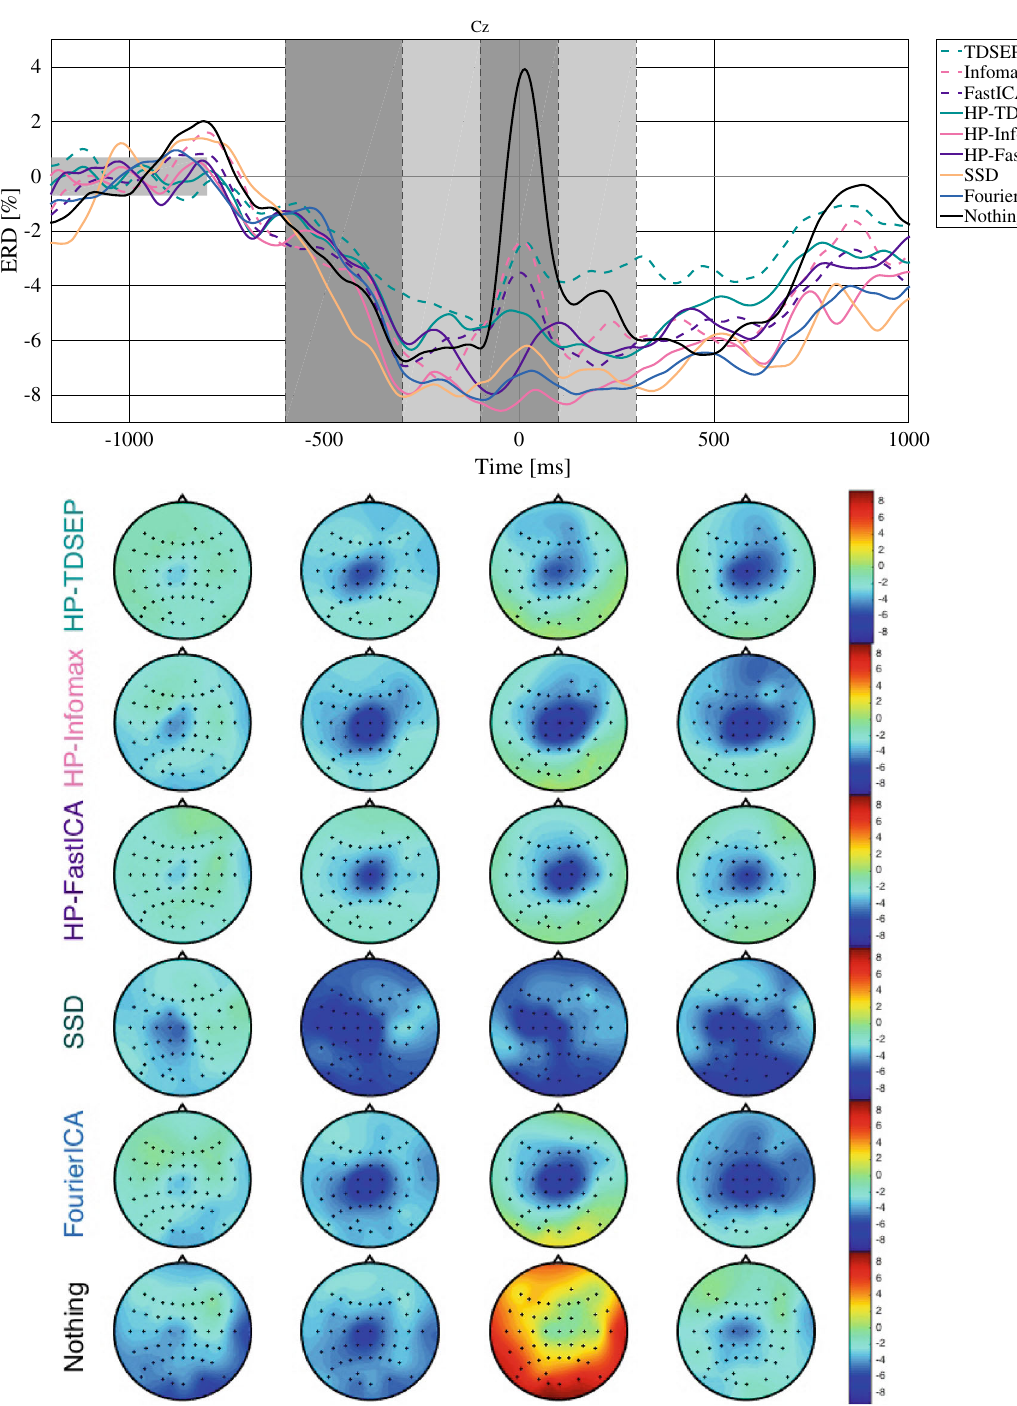
Fig. 2 Grand-average event-related desynchronization (ERD) in the beta band (15–30 Hz), using EMG as a trigger. (Top) time courses of data reconstructed from neural ICs (and for SSD with the five dipolarity score as dependent variable. In contrast to the average ERD peak score, high-pass filtering had a signifi- cant negative effect on the dipolarity score ( F ð 1 ; 102 Þ ¼ 9 : 1 ; p \ 0 : 01). The second model compared